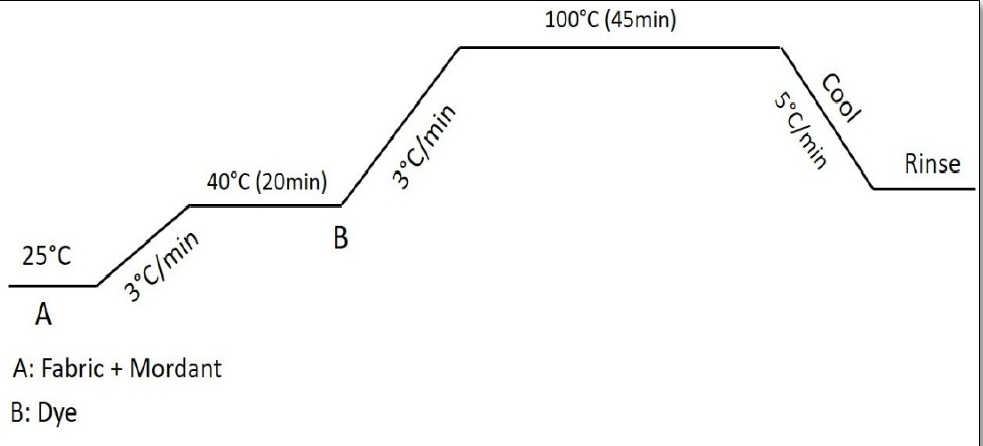
Figure 1. Simultaneous mordanting dyeing process.